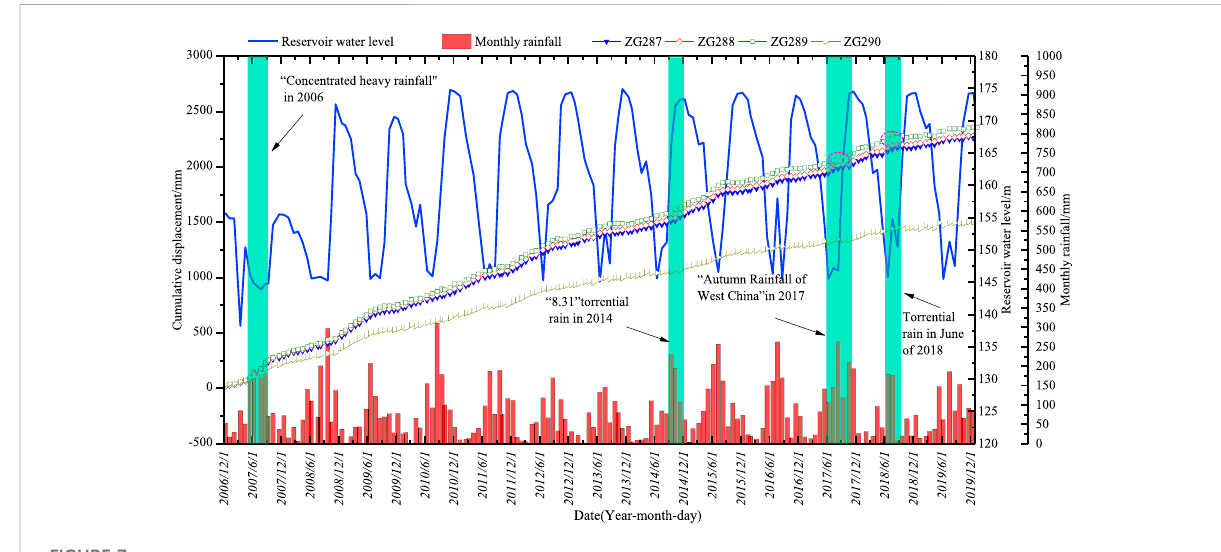
FIGURE 7 Cumulative displacement-time curve of arti fi cial GPS monitoring points of Tanjiahe